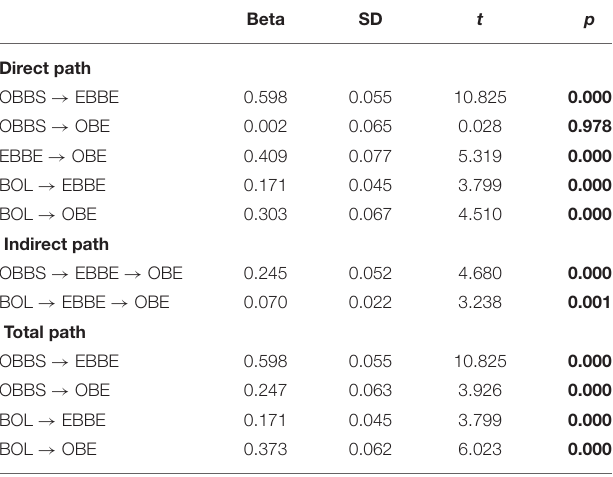
TABLE 6 | Direct, indirect, and total path